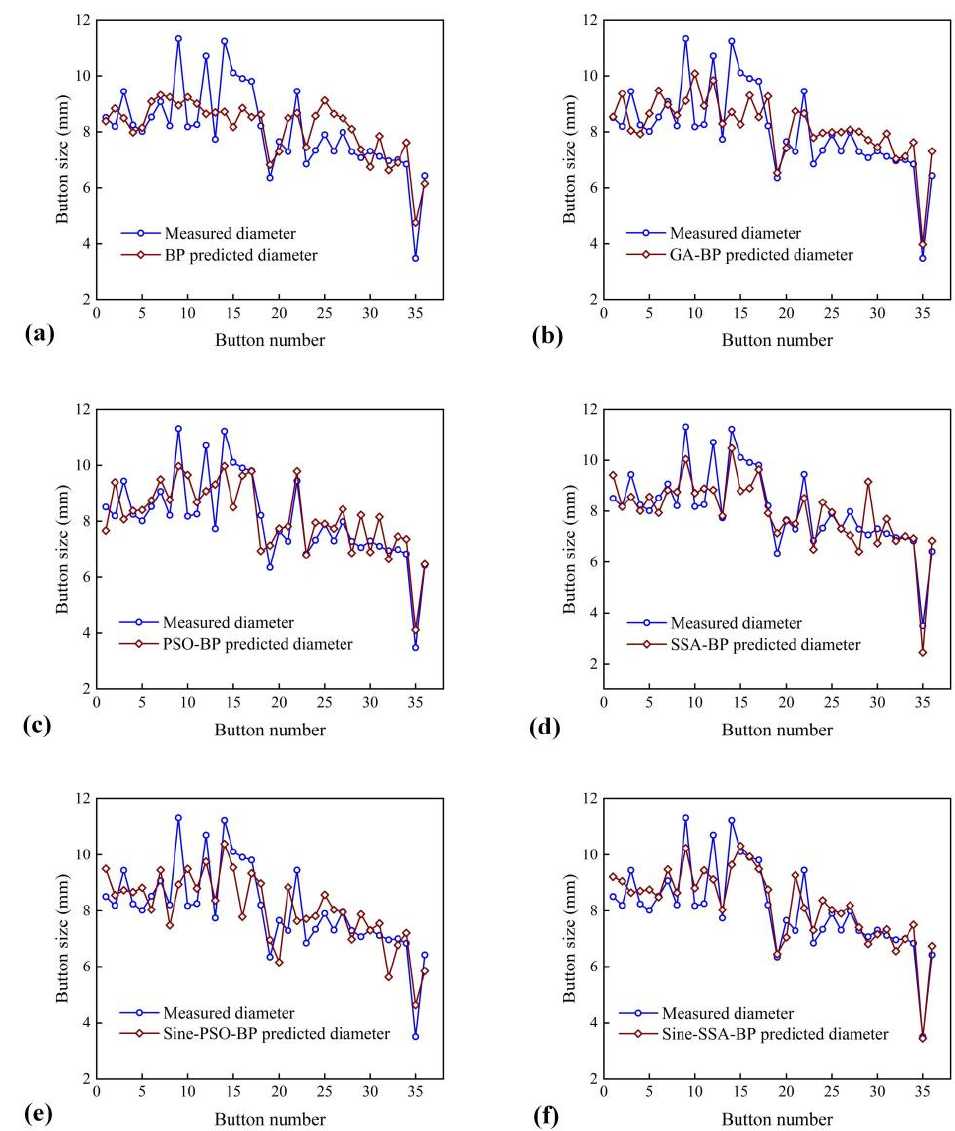
Figure 11. Comparison of measured value and predicted value of various prediction models: ( a ) BP; ( b ) GA-BP; ( c ) PSO-BP; ( d ) SSA-BP; ( e ) Sine-PSO-BP; ( f ) Sine-SSA-BP.